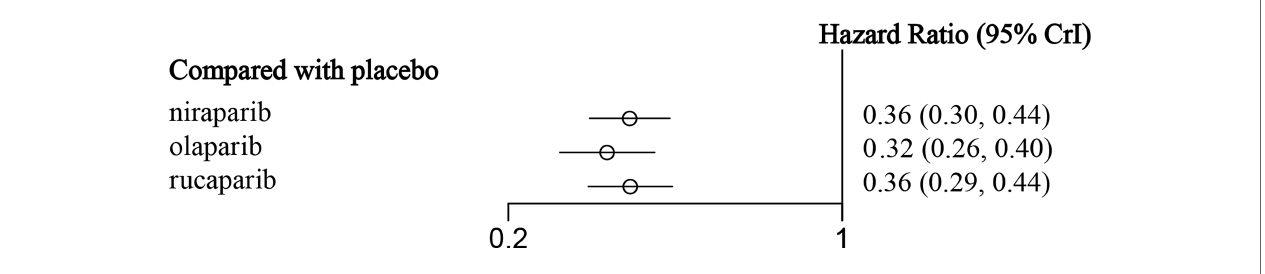
FIGURE 5 | The forest plot of PFS in the overall population.